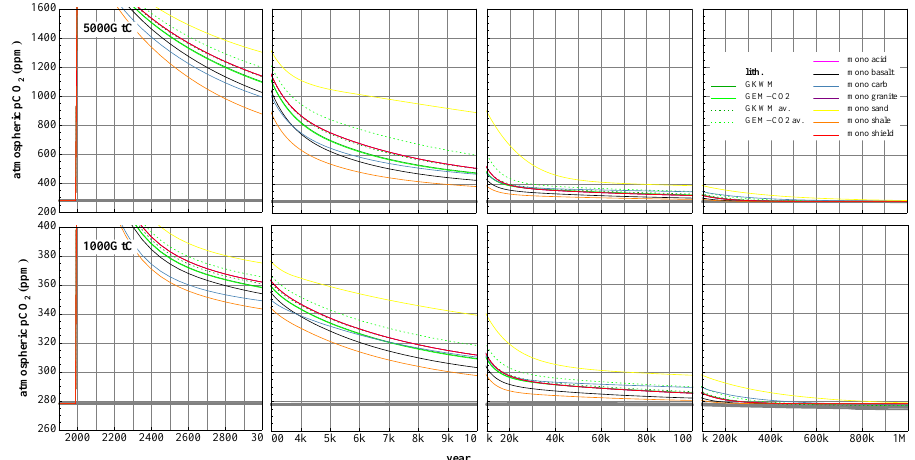
Fig. 21. The effect of carbonate and silicate weathering feedbacks (f_Ca and f_Si respectively) on atmospheric CO 2 concentrations over 1Myr for 1000GtC (bottom) and 5000GtC (top) emissions pulses, for the 0-D Globavg (solid lines) and 2-D GKWM (dashed lines) weathering schemes. Control runs with no emissions are shown in grey.